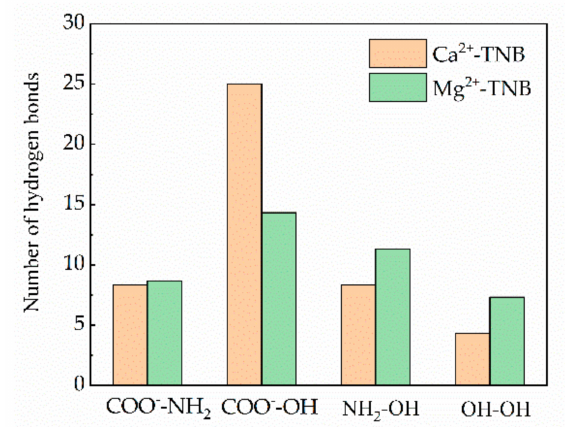
Figure 9. Number of hydrogen bonds between functional groups of